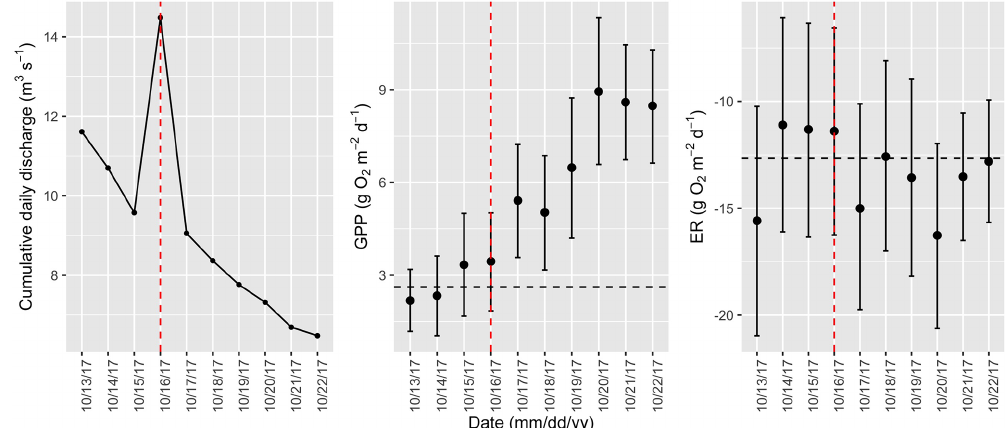
Figure A18. Cumulative daily discharge and metabolism (gross primary production and ecosystem respiration; GPP and ER) time series for the Stroubles Creek flow event on 16 October 2017 (noted with a dashed vertical red line in all three panels). The dashed horizontal black lines are mean values of GPP and ER prior to the high flow event. Error bars for posterior estimates of GPP and ER are 2.5% and 97.5% Bayesian credible intervals.